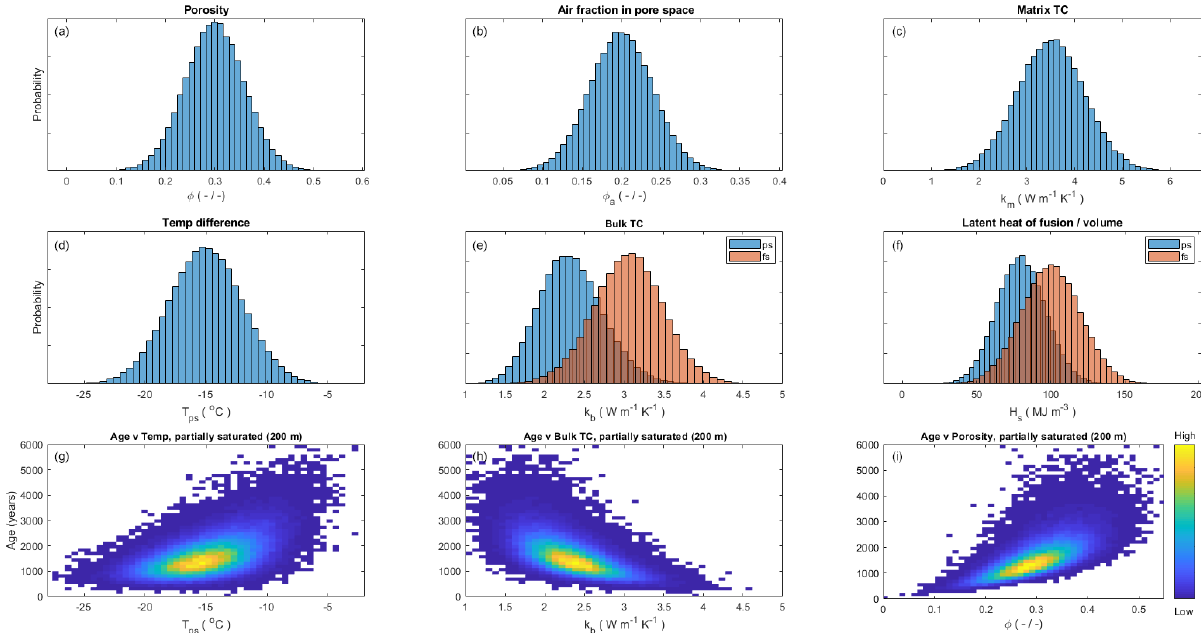
Figure 10. Monte Carlo sensitivity analysis of permafrost age inputs; k b and H s include partially saturated (ps) and fully saturated (fs) substrate conditions. Panels (g) – (i) show how variations in temperature, bulk TC, and porosity affect the age of permafrost. Data density is displayed as a color ramp, where yellow points indicate higher data density, and blue points indicate lower data density.